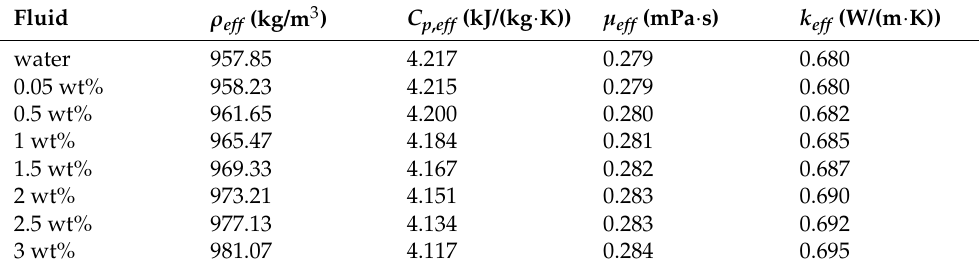
Table 4. Thermophysical properties of the working fluids, at saturation temperature (373.15 K = 100 ◦ C) and atmospheric pressure (1.013 × 10 5 Pa).